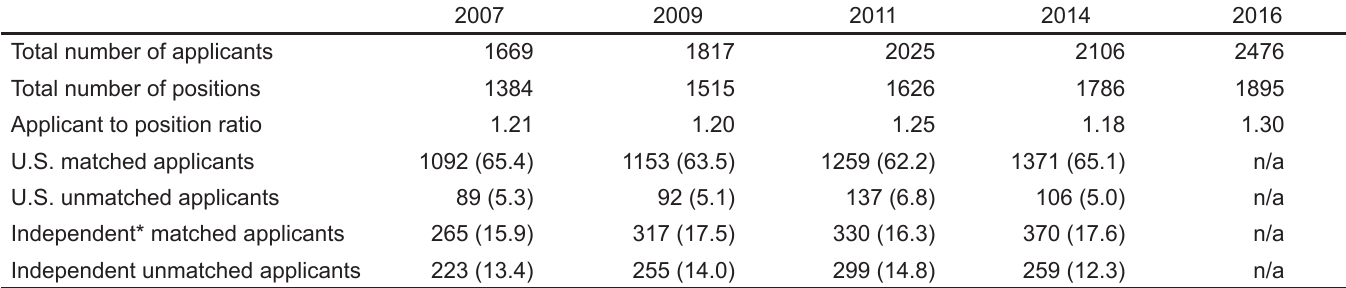
Table 1. Number of applicants to emergency medicine residency programs from 2007 to 2016. Data are presented as counts and percentages. Subgroup data not available (n/a) for 2016.